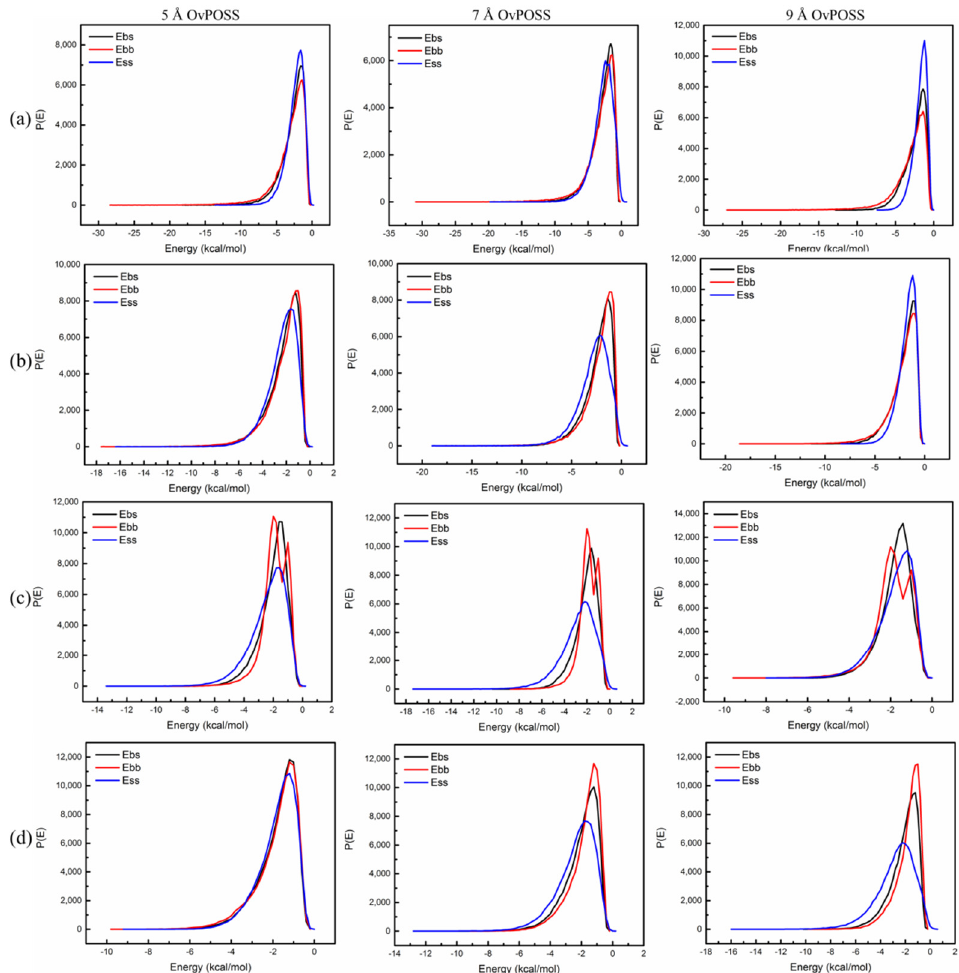
Figure 10. The probability distribution of mixing energy of nano-OvPOSS (5 Å OvPOSS, 7 Å OvPOSS, and 9 Å OvPOSS) with four asphalt components: ( a ) asphaltene; ( b ) resin; ( c ) saturate; ( d ) aromatic.